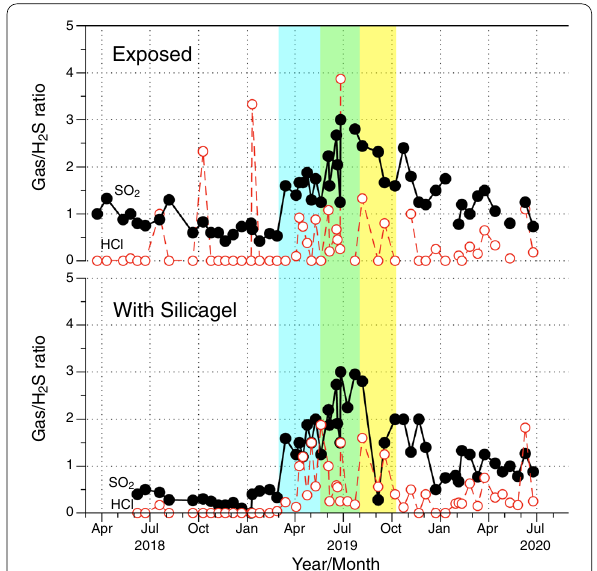
Fig. 8 Sequential change of magmatic components (SO 2 and HCl) relative to a hydrothermal component (H 2 S) within the atmosphere near the 15–2 fumarole, measured by dosi-tubes. Each panel shows values obtained by a set of dosi-tubes exposed to the air (upper panel) and another set within a container filled with silica gel (lower panel). The durations of volcanic unrest episodes are shown as shaded yellow (VAL2 or more) and blue (baseline across the volcano is increasing). See caption of Fig. 3 for details. The spikes in HCl/H 2 S ratio of the exposed set (HCl/H 2 S > 2) are considered to be errors caused by color changes due to steam precipitation within the tube